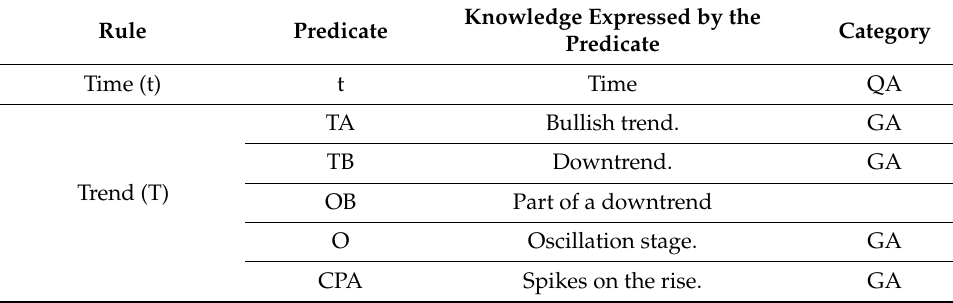
Table A2. Notation used in the